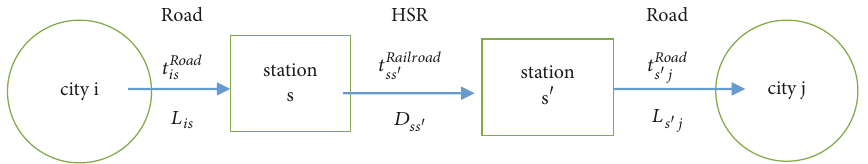
Figure 3: Travel diagram from city i to city